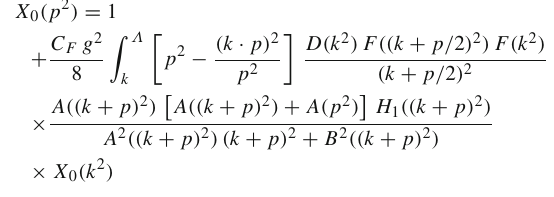
Fig. 10 The scalar (top) N ( 3 ) ( p , q )/ p 2 kernels including the term of the gluon propaga- N ( 3 ) A tor as defined in (61). See also the caption of Fig. 6